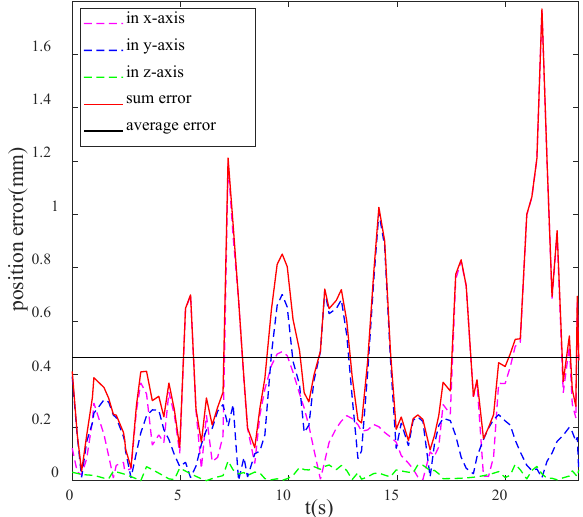
Figure 12. Position tracking error in the X -axis , Y -axis, Z -axis direction and total position